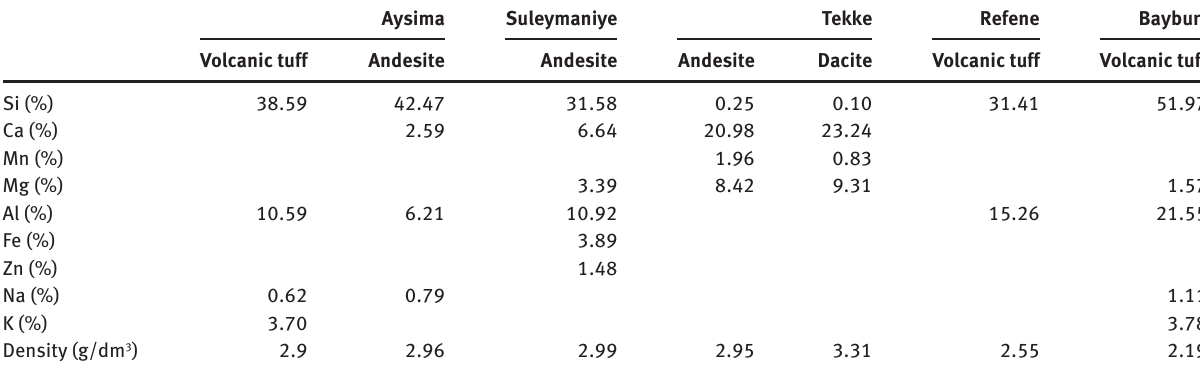
Table 8 The chemical compositions and density of the volcanic rocks.